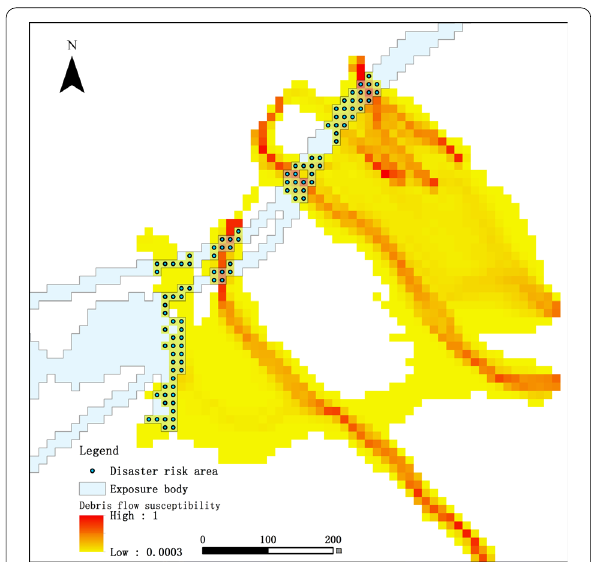
Fig. 15 A schematic diagram of overlapping parts of debris-flow susceptibility identification and infrastructure is used to distinguish debris flow risk (The points refer to the physical environment of the study